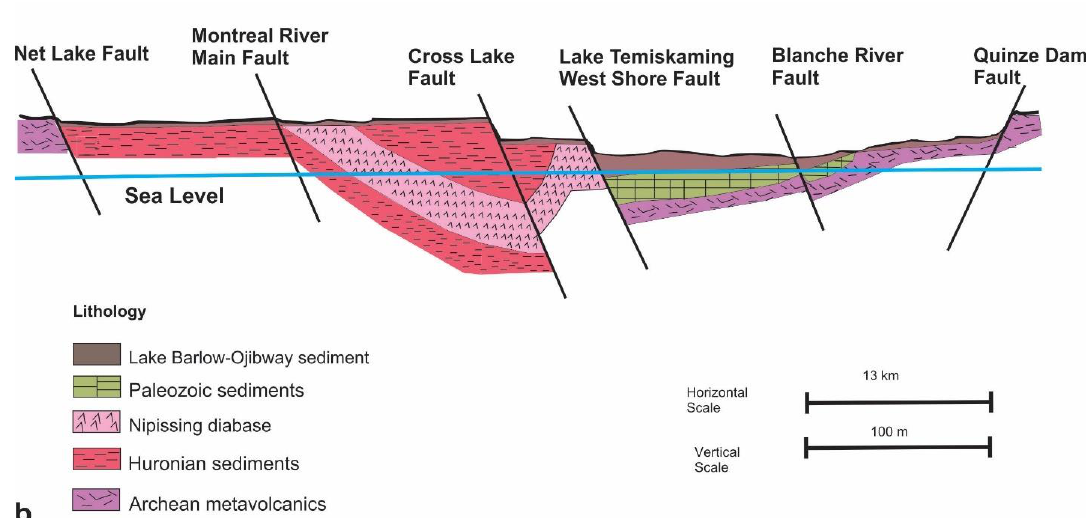
Figure 2. Structural elements characterizing the Temiskaming Graben. ( a ) 30 m ALOS DEM overland with Hillshade map (illumination from 45°) that highlights the lineaments; ( b ) simplified geological cross section of the Temiskaming Graben from [63] (note that the Net Lake Fault is not represented in ( a )).